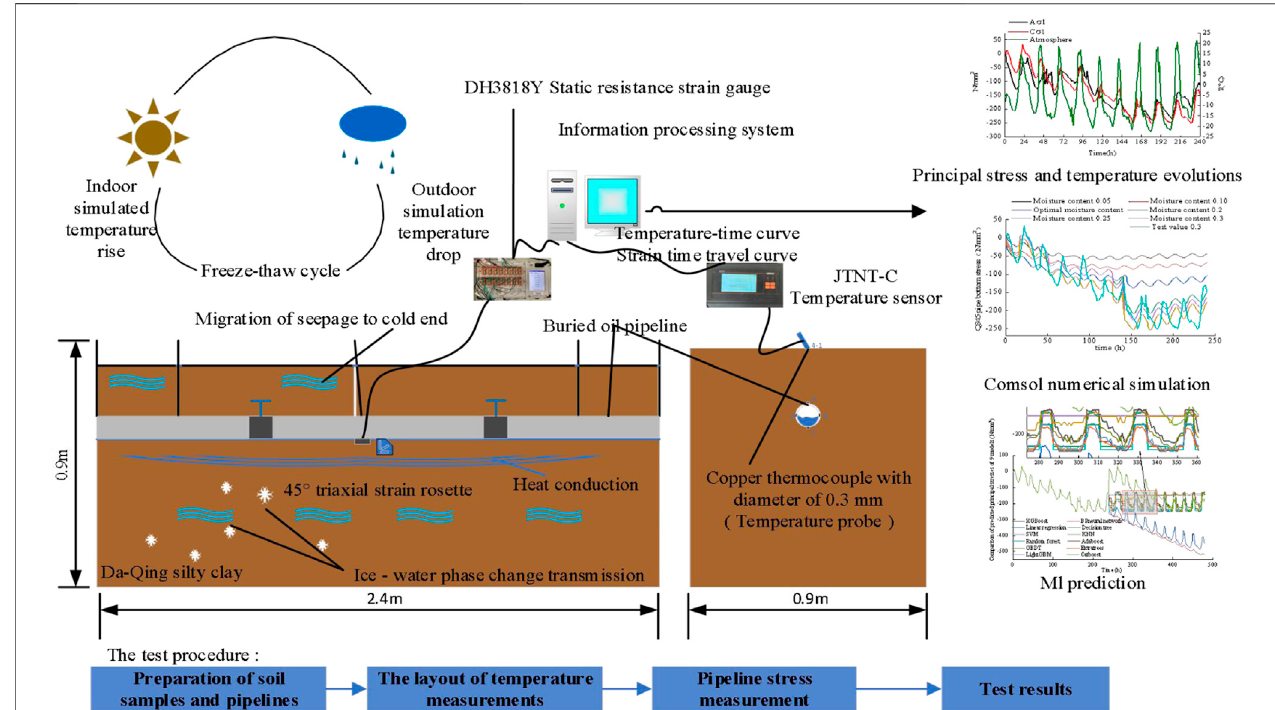
FIGURE 1 | Schematic diagram of the test